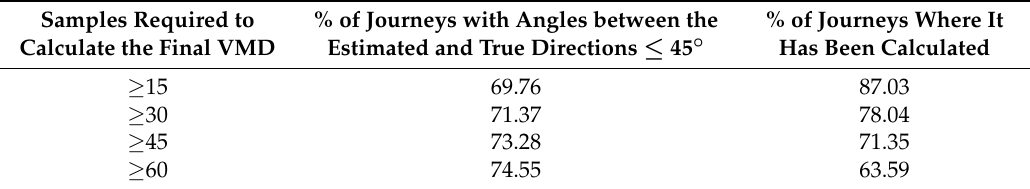
Table 4. VMD results using horizontal